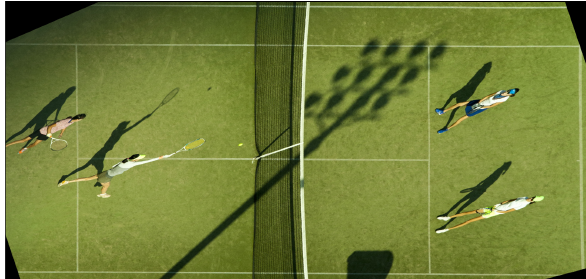
Figure 7. Rectified tennis court (Photo by HeungSoon, 2016). The original photo shows a scene of a tennis game in oblique perspective. The ground plane was rectified assuming a standard 78ft by 36ft tennis court. Objects not on the ground plane (like the players and the net) appear distorted. They are projected through the camera center onto the ground